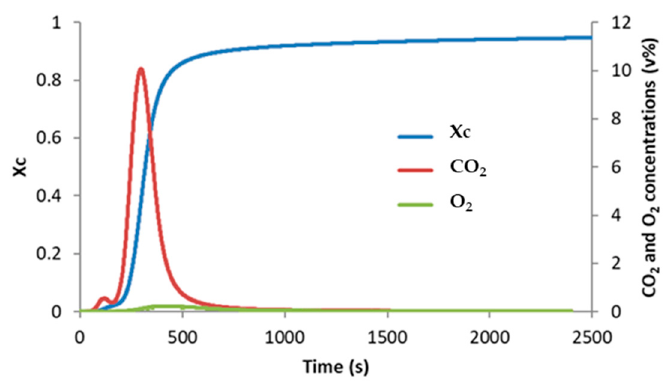
Figure 8. The carbon conversion efficiency Xc and generated CO 2 concentration (v%) in the reduction